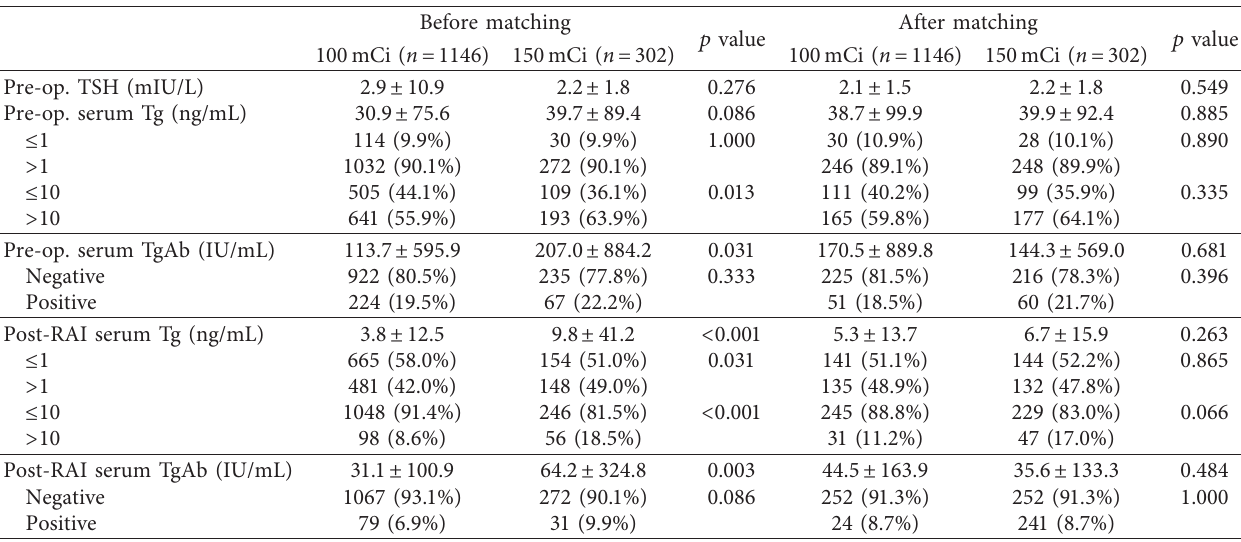
Table 2: Comparison of perioperative biochemical characteristics between intermediate- (100mCi) and high-dose (150mCi) groups before and after propensity score matching.